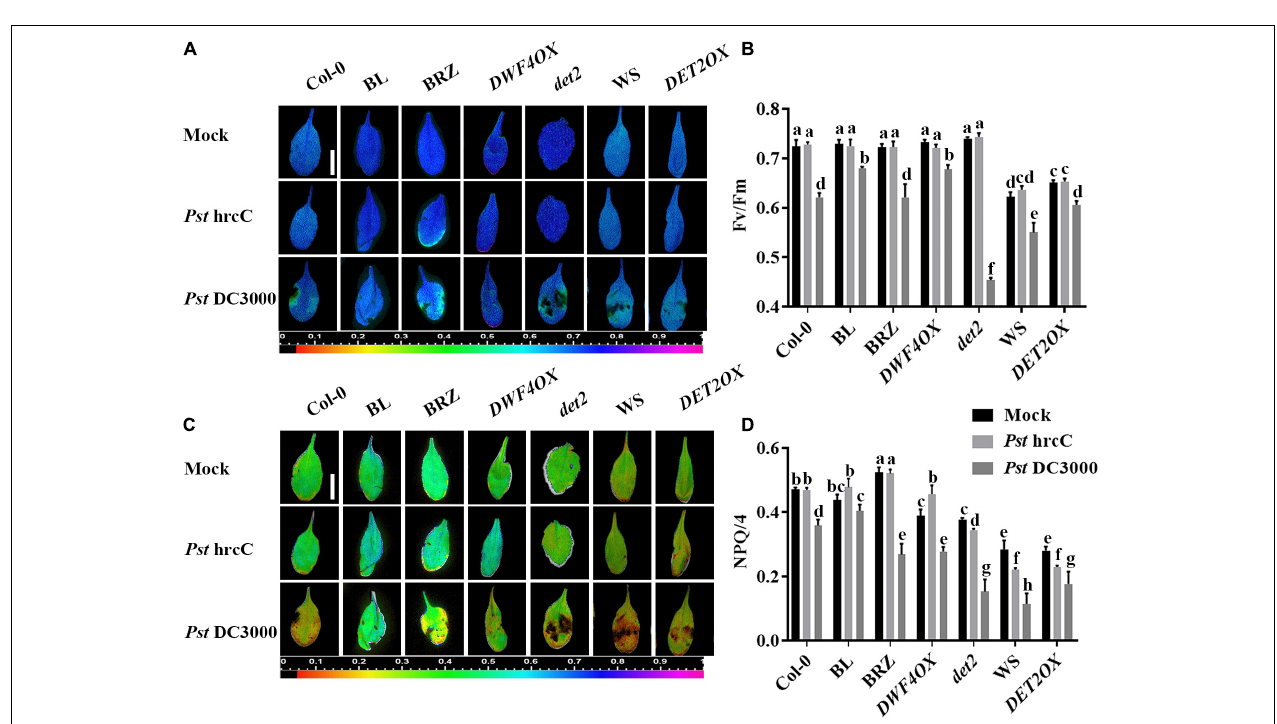
FIGURE 2 | Brassinosteroids alleviate photosystem damage after Pst DC3000 infection. Images of the maximum photosystem II (PSII) quantum yield ( F v/ F m) (A) and non-photochemical quenching (NPQ)/4 (C) in the leaves infected by Pst DC3000 or Pst hrcC at 3 dpi. Bar, 1.00 cm. Average values of F v/ F m (B) and NPQ/4 (D) for the respective chlorophyll fluorescence images. F v/ F m or NPQ/4 measured from 8 to 10 leaves and three biological repeats. Significant differences ( P < 0.05) are denoted by different lowercase letters.